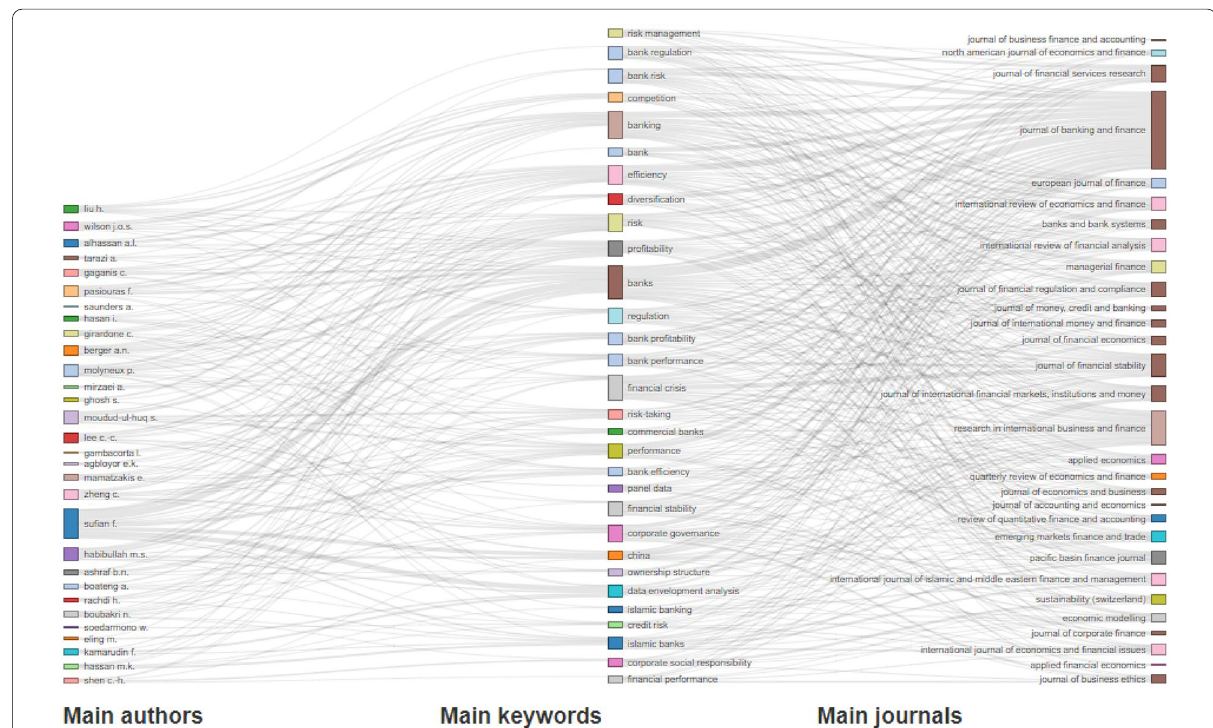
Fig. 6 Sankey Diagram of main authors, keywords, and journals. Note Authors contribution using scientometrics